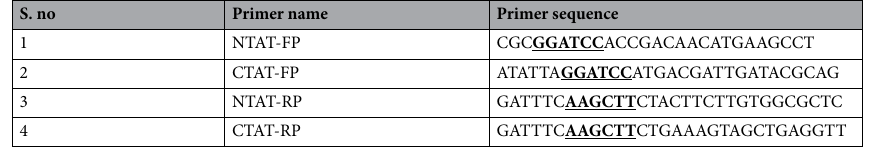
Table 2. Gene-specific primers: Primers synthesized and used for the amplification of NTAT and CTAT. The restriction sites utilized for cloning of the genes are marked in bold and